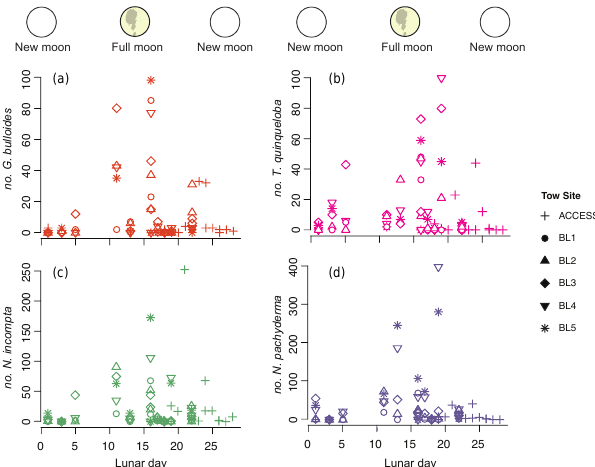
Figure 8. G. bulloides, T. quinqueloba , N. incompta , and N. pachy- derma counts by lunar day from the new moon (day 0) to full moon (Day ∼ 14). Abundances are taken from integrated tows, at 25, 45, 90, 120, and 200m depending on the station (see Table 1). Symbols denote tow